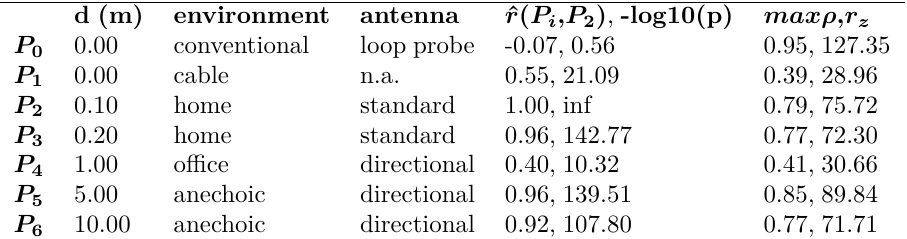
Table 4: Similarity among profiles (ˆ r ( P i ,P 2 )) and strength of the leak ( maxρ,r z ) for different distances and setups. All profiles taken for screaming channels are similar, showing that the distortion of screaming-channel leaks is constant. The amount of correlation stays high despite distance, and it rather depends on the quality of setup and